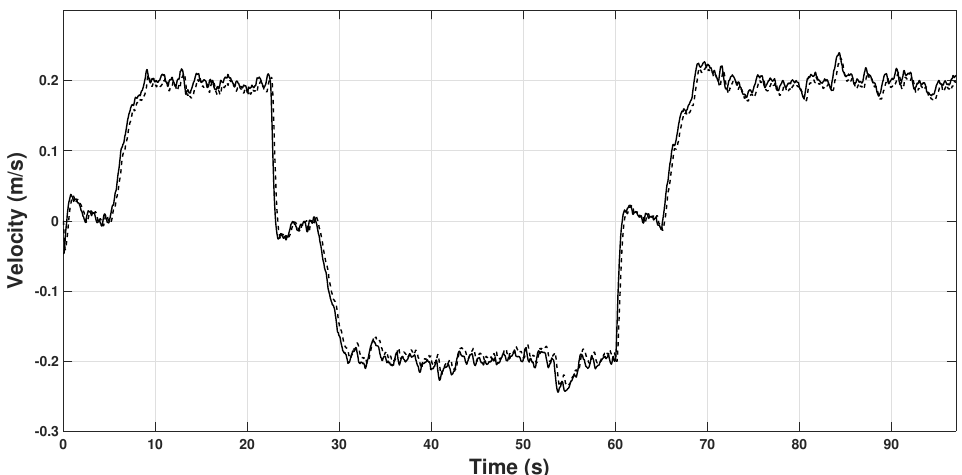
Figure 7. Observed speed on the Y b axis. v (continuous line), β 1 y (dashed line).